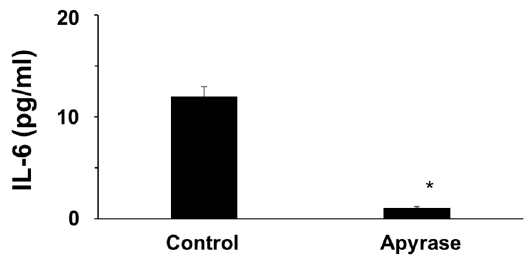
Figure 7 . Effects of extracellular ATP hydrolysis with apyrase on IL-6 secretion by human adipocytes (* p < 0.001). (* p <